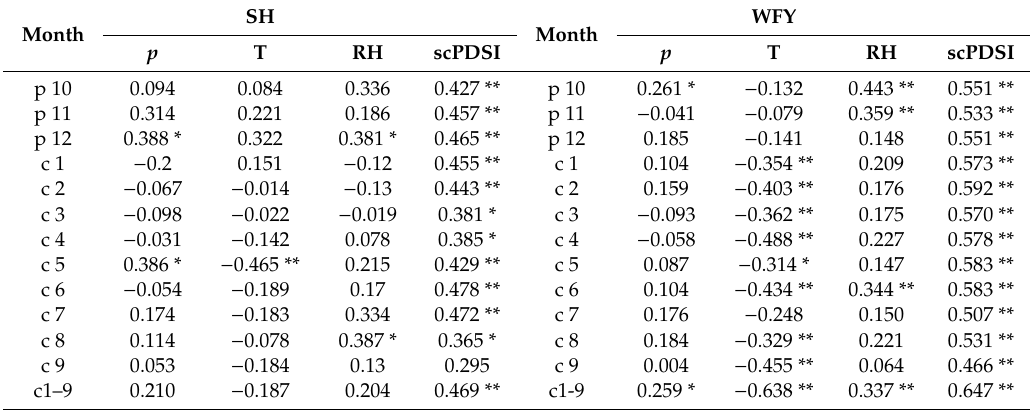
Table 2. Correlations between tree-ring width chronologies of SH and WFY and climatic